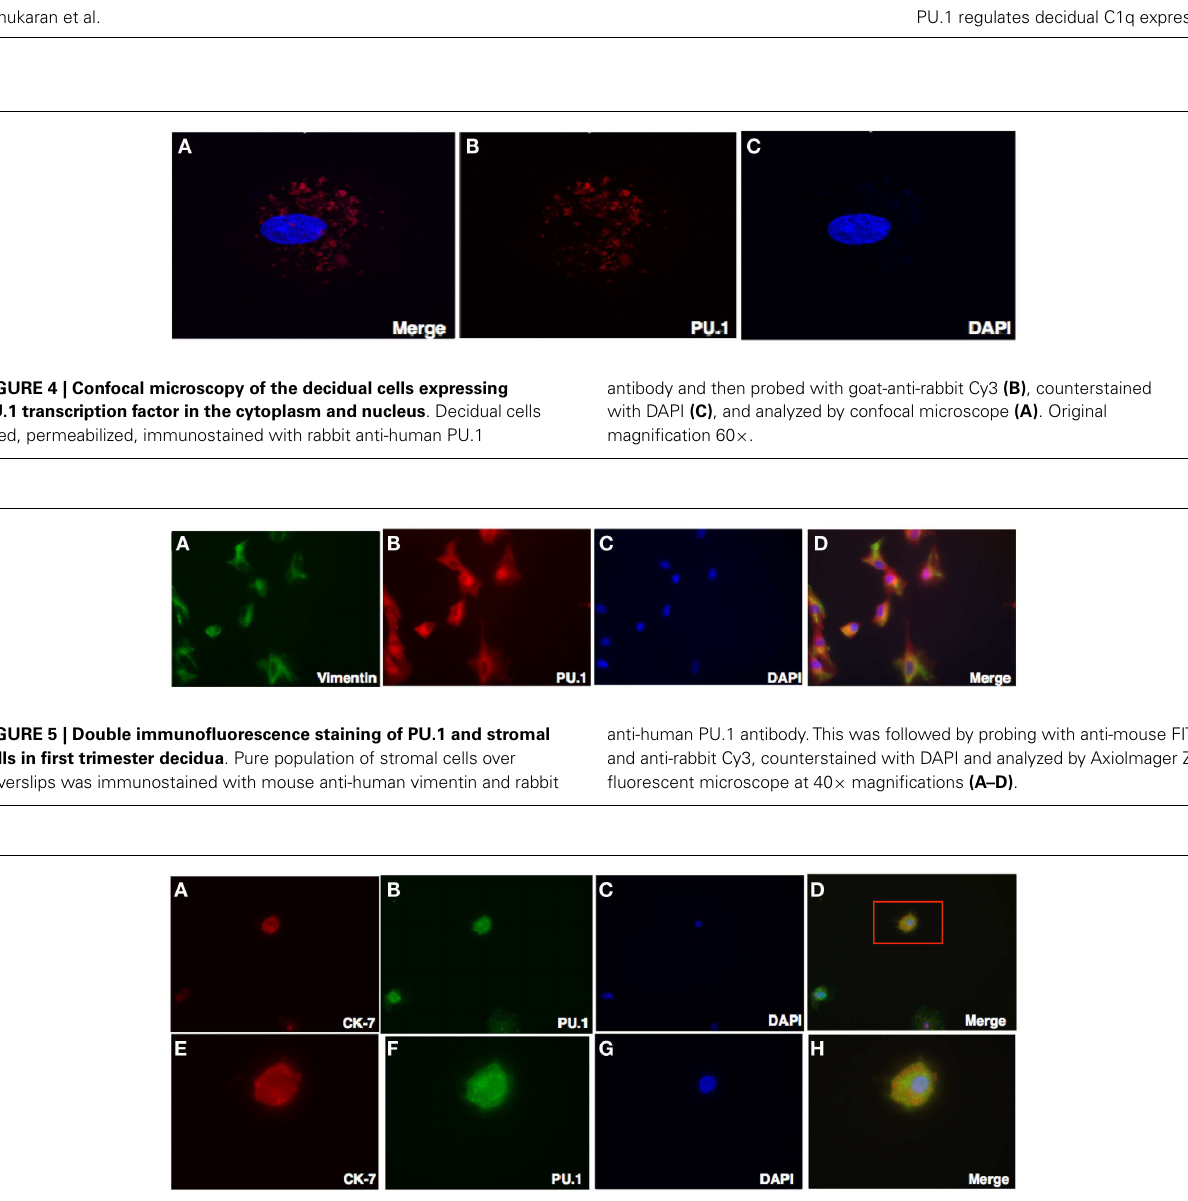
Cy3 and anti-rabbit FITC conjugates, counterstained with DAPI and analyzed by Axiolmager Z1 fluorescent microscope at 40 × magnifications (A–D) . Cells in red box (D) indicate the same at higher magnification, 100 × oil immersion stained with CK-7, PU.1, DAPI, and overlay in (E–H)